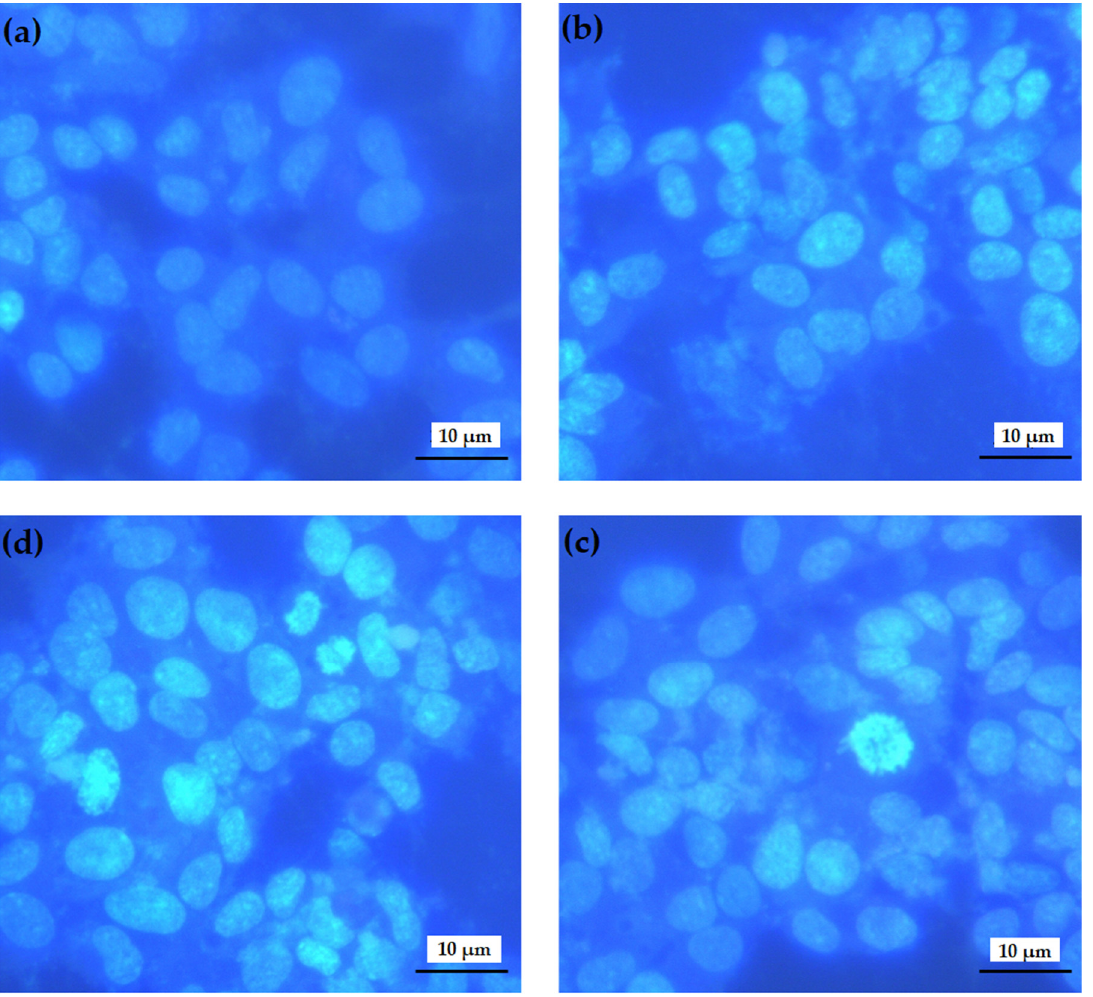
Figure 11. Effects of hBN-NPs and A β on morphological changes in differentiated SH-SY5Y cells: ( a ) untreated SH-SY5Y cells, ( b ) hBN-NPs (10 mg/L), ( c ) cell culture containing only A β , ( d ) hBN-NPs plus A β in 40× magnification.